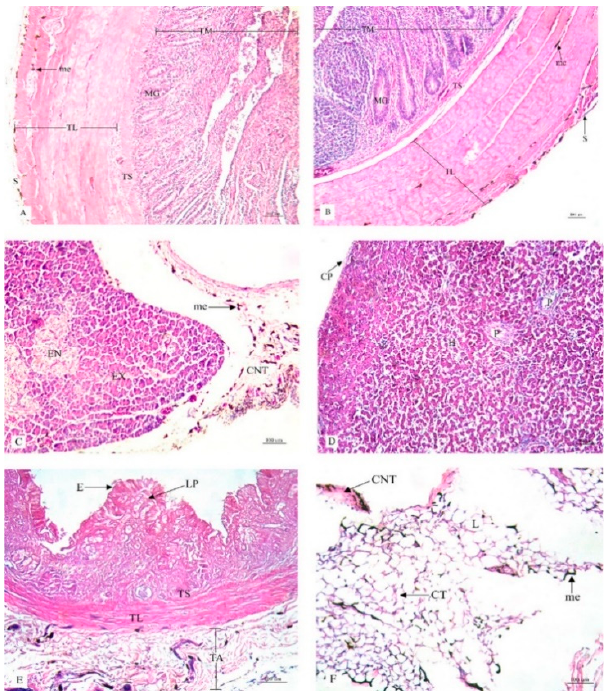
Figure 5. Histological location of melanin pigment in each organ; ileum ( A ), cecum ( B ), pancreas ( C ), liver ( D ), gall bladder ( E ), omentum ( F ). Abbreviations: S, tunica serosa; TL, tunica muscularis; TS, tunica submucosa; TM, tunica mucosa; MG, mucous gland; EX, exocrine; EN, endocrine; CNT, connective tissue; CP, capsule; H, hepatic lobule; P, portal tract; TA, tunica adventitia; E, epithelium; LP, lamina propria; CT, cytoplasm; L, lipid droplet; me, melanin pigment. Low magnification, H&E stain.